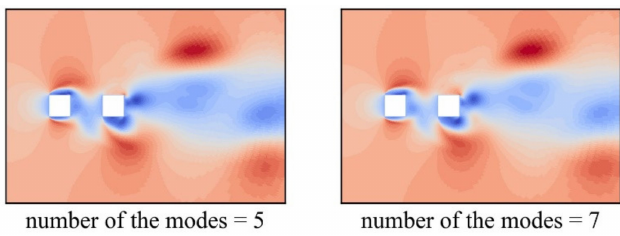
Figure 8. Reconstruction of transverse velocity U of flow field when L / D = 2.5.